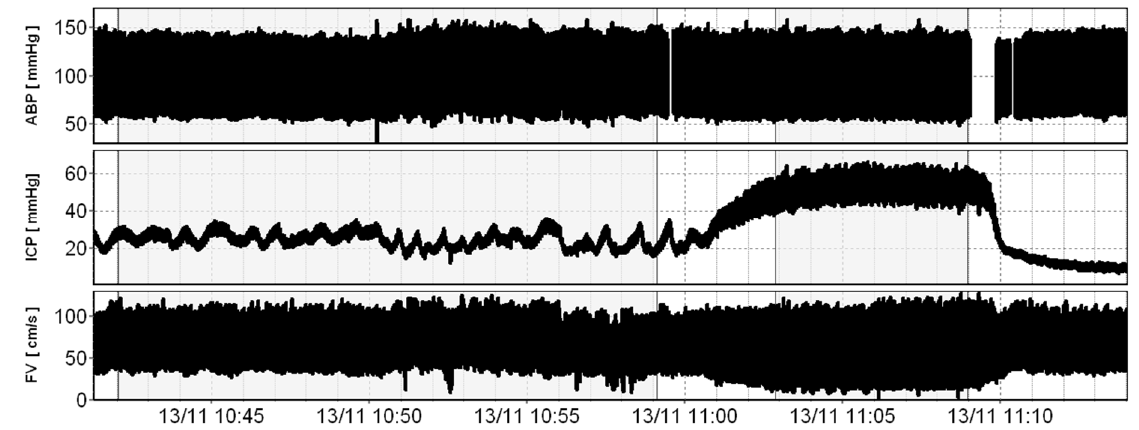
Figure 1. A recording of a plateau wave preceded with baseline. Analysed periods are shaded.